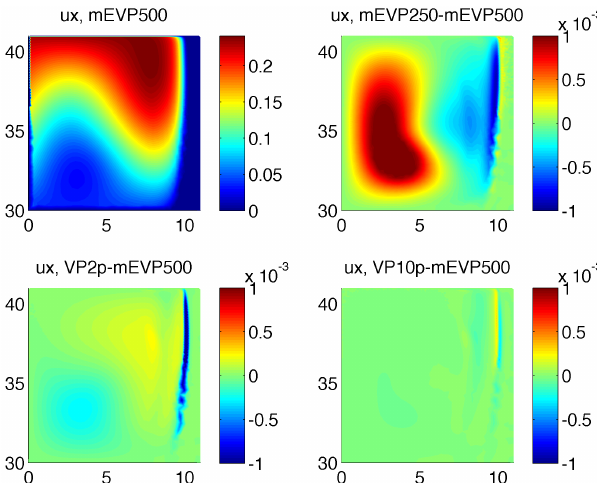
Figure 2. Ice zonal velocity (ms − 1 ) in case A (advection is switched off) after 1 month of simulations in mEVP500 (top left) and differences between the solutions obtained by different meth- ods: mEVP250-mEVP500 (top right), VP2p-mEVP500 (bottom left) and VP10p-mEVP500 (bottom right). mEVP250 does not con- verge, and VP2p is closer to convergence but still with noticeable errors. Additional Picard iterations in PV10p substantially reduced differences between the mEVP and VP